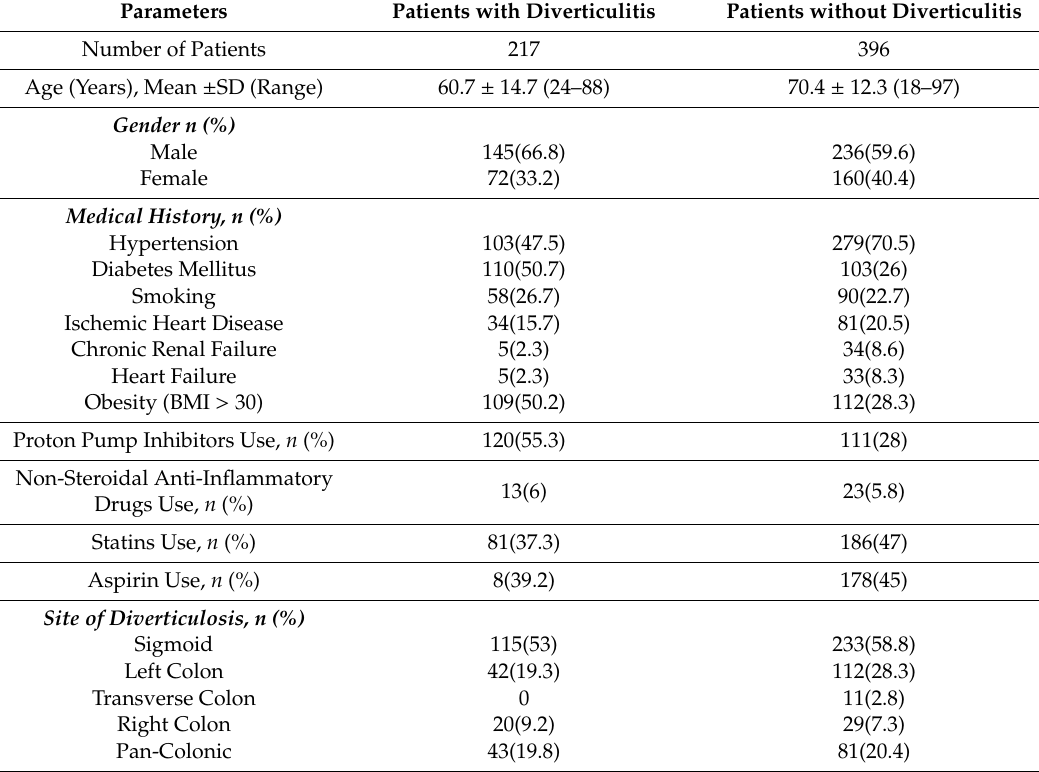
Table 1. Demographics and baseline characteristics of study